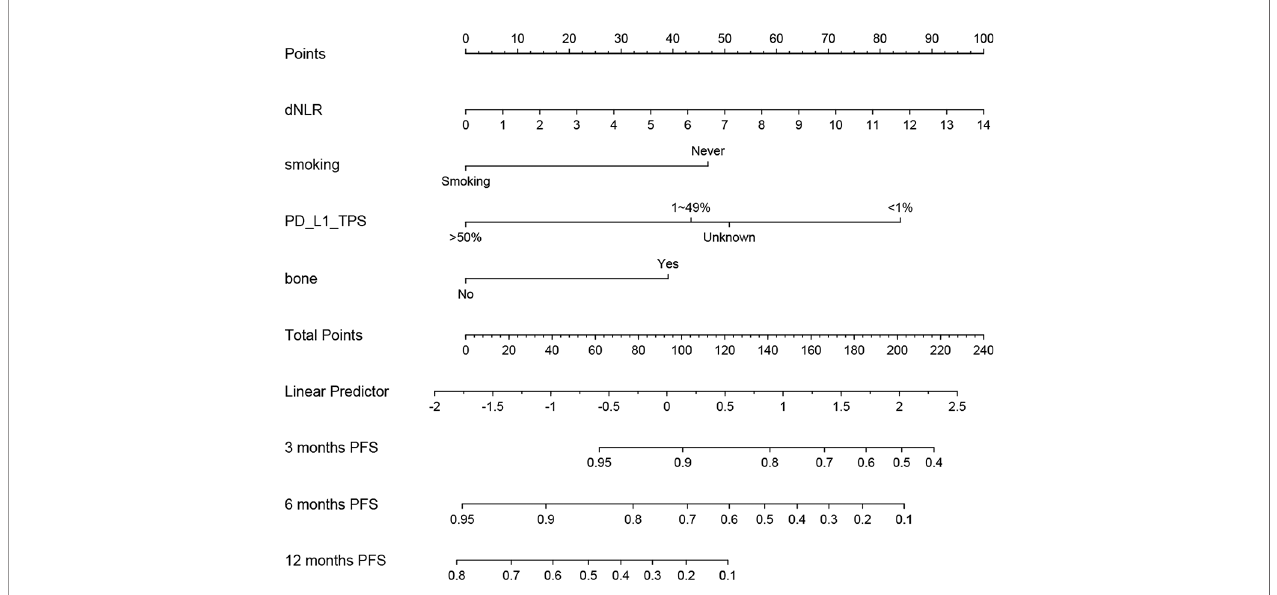
FIGURE 3 | Prognostic nomogram for non-small cell lung cancer (NSCLC) patients treating immune checkpoint inhibitors (ICIs) plus chemotherapy to assign their probability of progression-free survival (PFS) at 3, 6, and 12